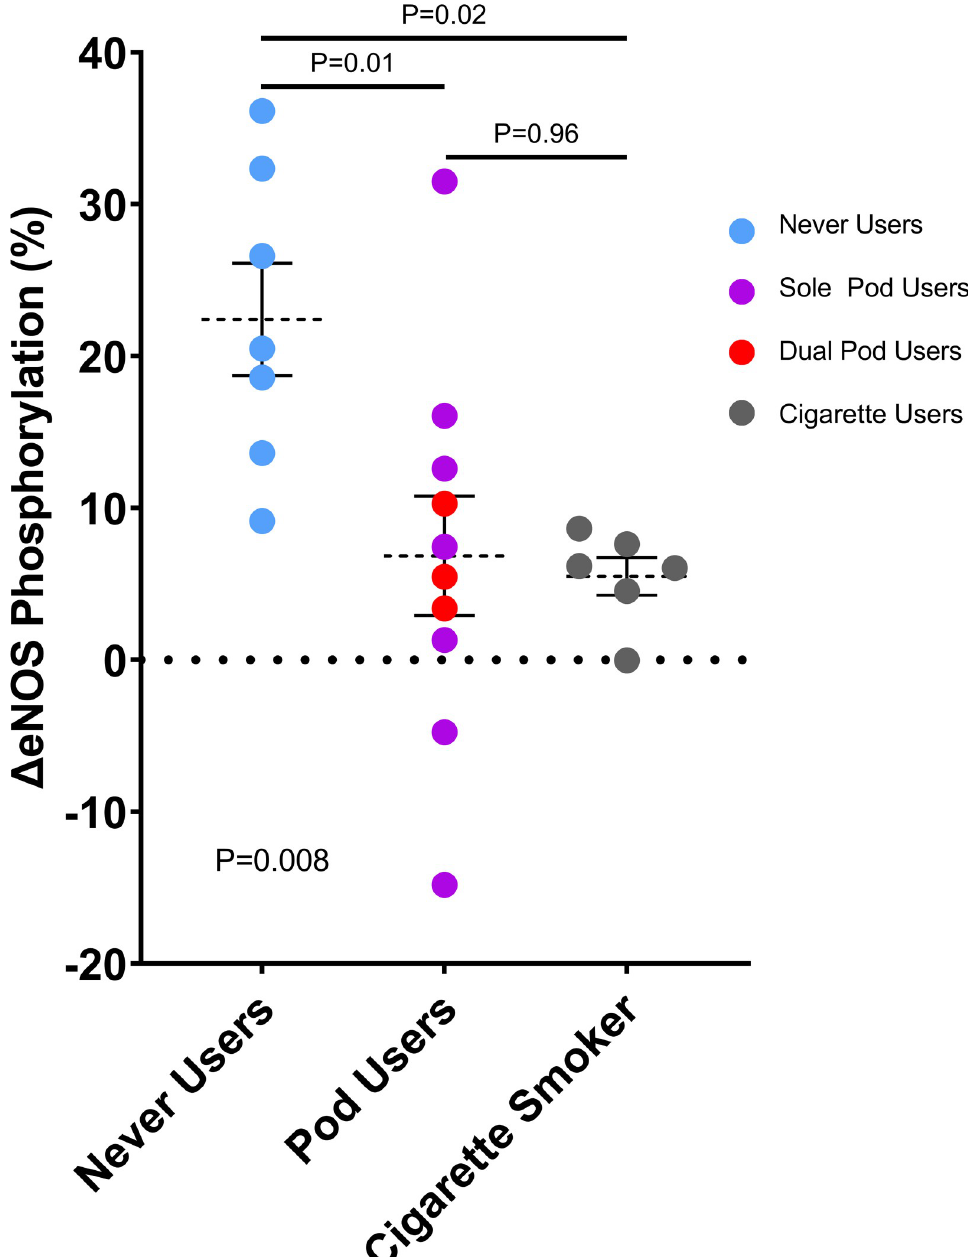
Fig 1. eNOS activation is impaired in endothelial cells from individuals who use pod-based e-cigarettes to a similar degree as combustible cigarette use. Ser-1177 phosphorylation was compared between the unstimulated and acetylcholine stimulated endothelial cells and evaluated as a percentage change. Data are plotted as individual measurements for each participant, mean and standard error of the mean compared by ANOVA with Tukey post-hoc testing for between group comparisons. Cigarette = combustible